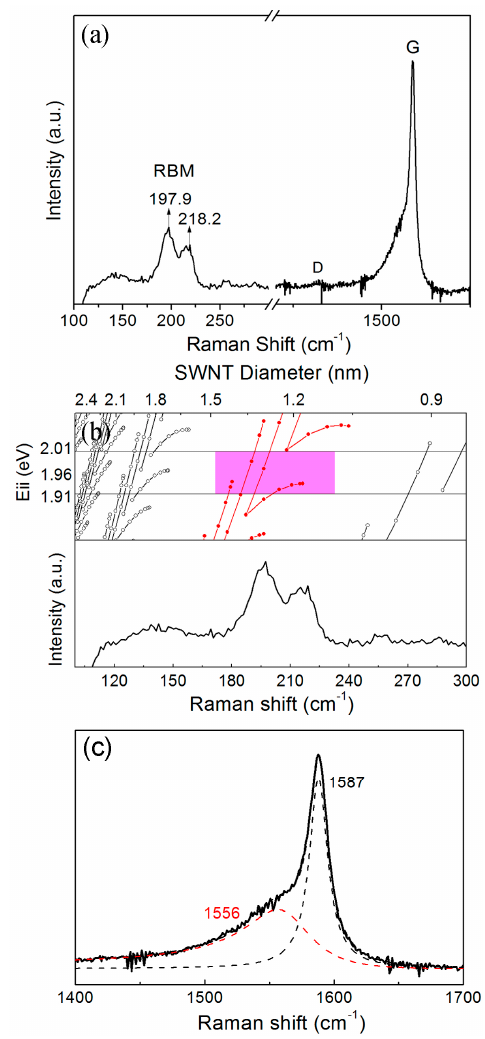
Figure 3. ( a ) Raman spectrum; ( b ) E ii - d plot or Kataura plot (upper panel) and radial breathing mode (RBM) region; and ( c ) G band of the SWCNT–ZnS nanocables.